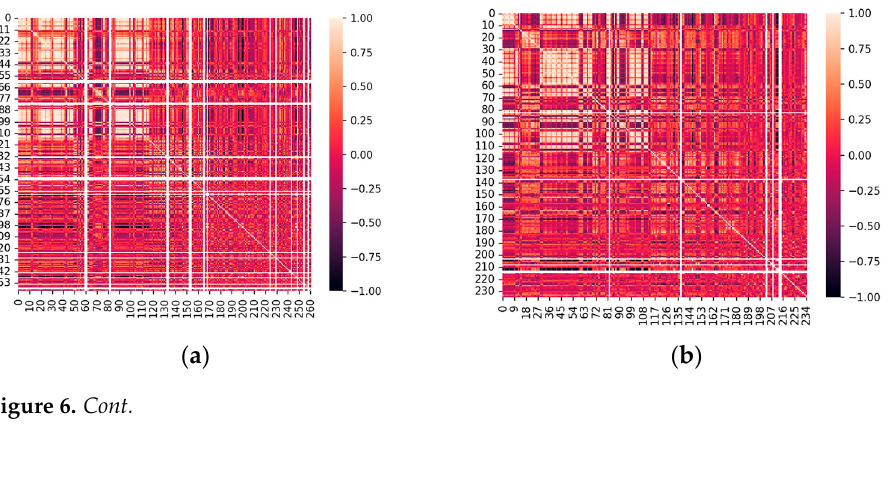
Table 3. Number of feature-processed features for each data set.